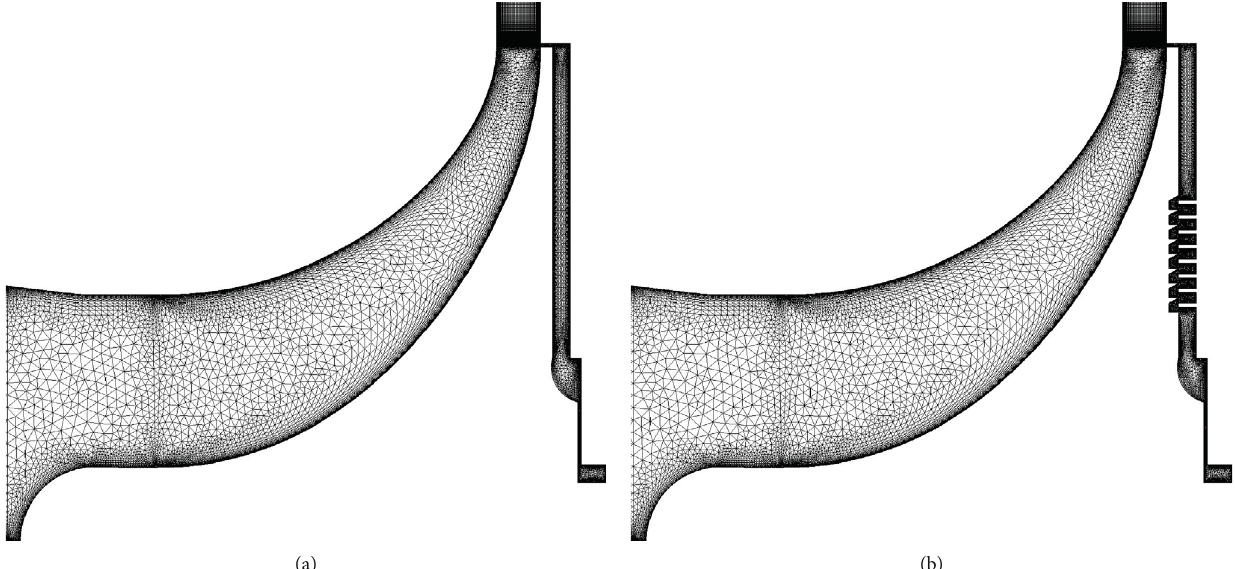
Figure 4: Mesh of the computational domain without (a) and with (b) the labyrinth